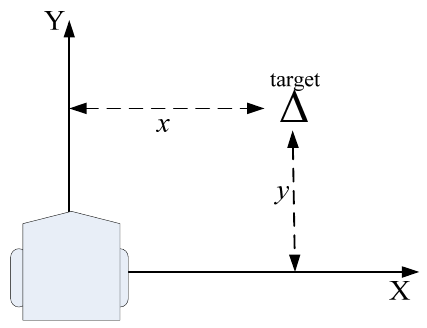
Figure 4. Relative coordinate of target with respect to wheeled mobile robot (WMR).